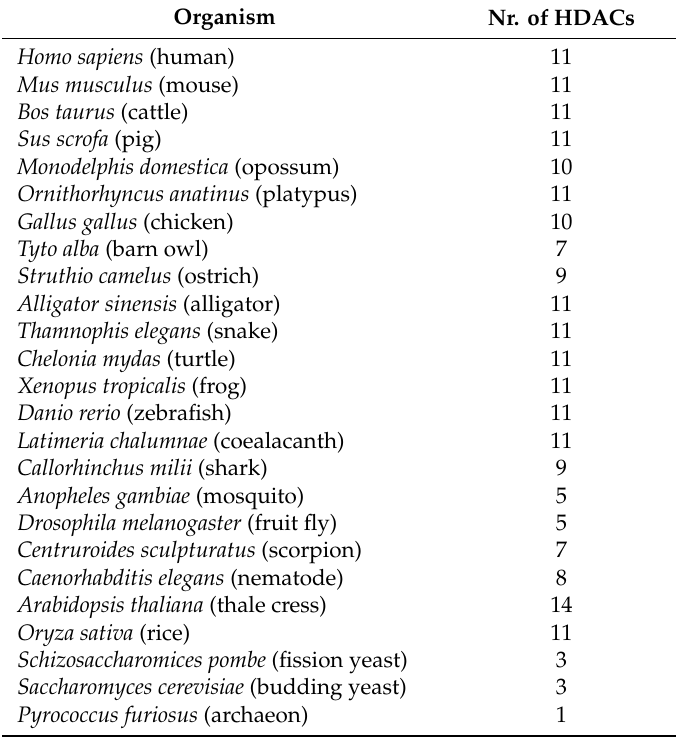
Table 2. Species selected for the phylogenetic analysis, with numbers of distinct HDAC genes detected. The analysis comprises a total of 223 protein sequences mapping to 25 organisms (24 eukarya and here but shown in Figure 1, were selected as outgroups to represent distance from the Bacteria